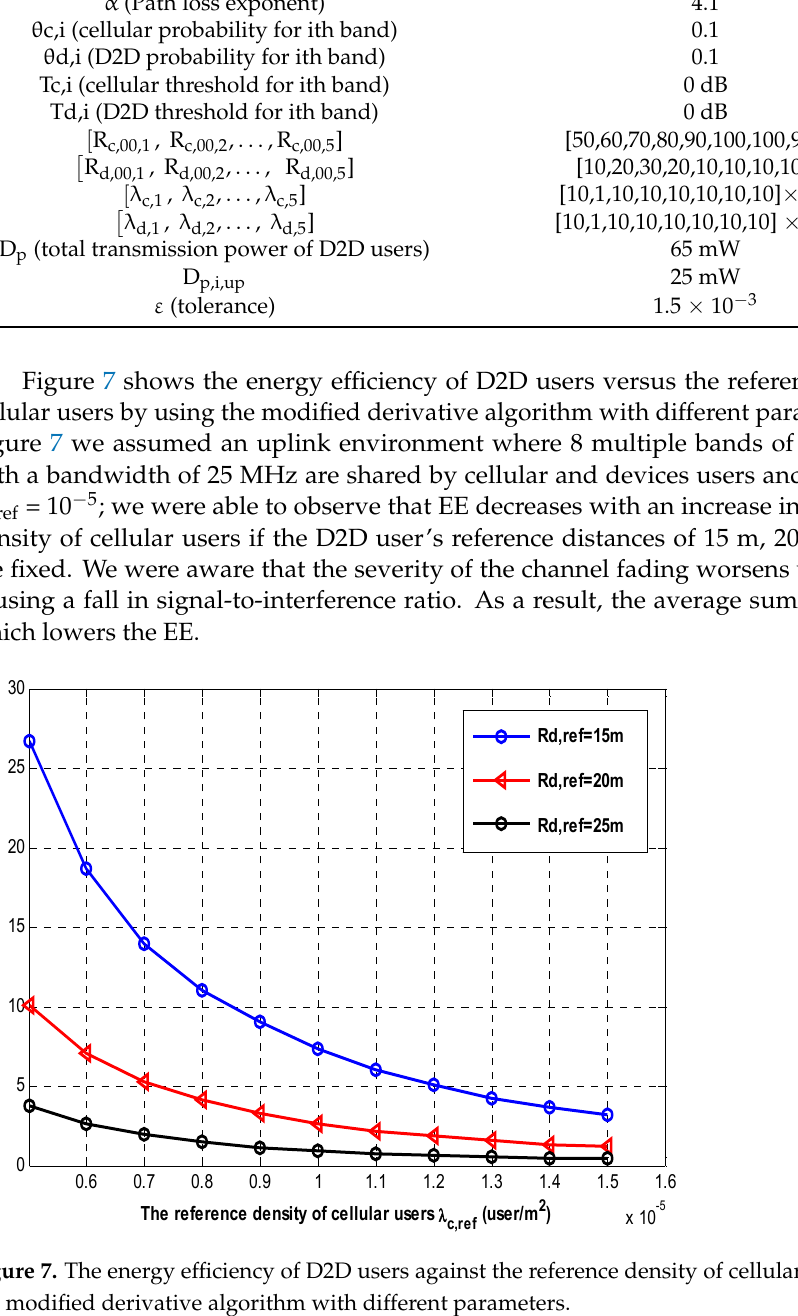
Table 3. Simulation parameters by using the modified derivative algorithm with different parameters.